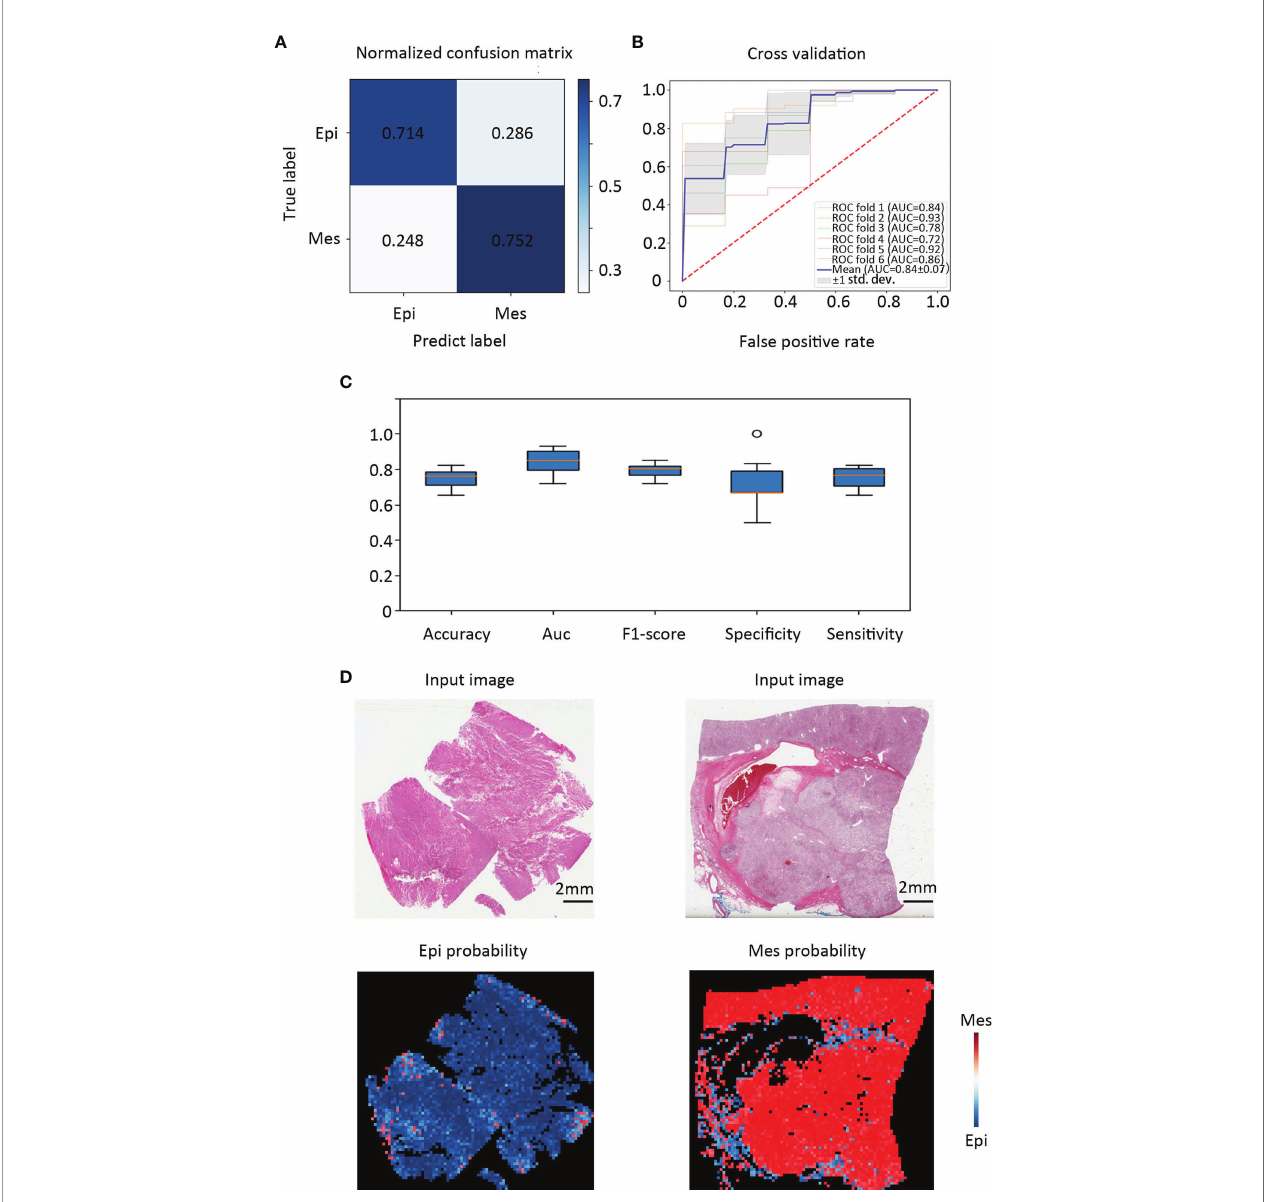
FIGURE 3 | Classi fi cation performance in an external validation set and class activation maps for morphological features. (A) Confusion matrix of the classi fi cation results of the validation patients. (B) Training and validation on TCGA cohort were performed using six-fold repeated validation with a 90% (training) to 10% (validation) strati fi ed, random split for each fold. (C) Classi fi er performance was assessed including accuracy, F1 score, AUC, speci fi city, and sensitivity separately for each EMT molecular subtype. (D) Tissue slides of patients with Epi and Mes tumors in TCGA test set show the spatial patterns of predicted MSI score. The top panel shows the H&E input image. Corresponding predicted Epi and Mes map for the image shown in the bottom panel. Class activation maps for morphological